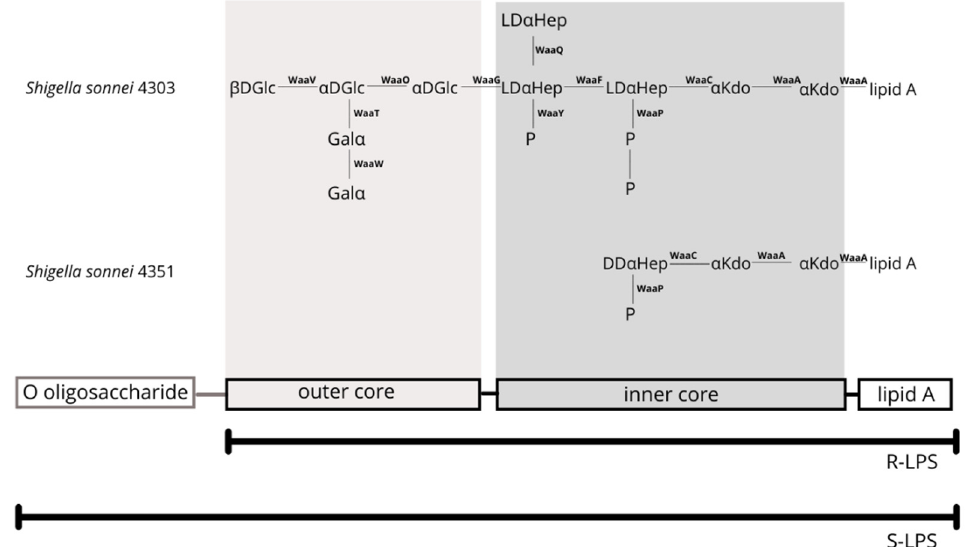
Figure 4. The structures of the R-type lipopolysaccharides from S. sonnei 4303 and S. sonnei 4351. No O-specific side chains are found in these bacteria. Genes involved in the LPS biosynthesis are indicated. The LPS in the S. sonnei 4351 strain contains a truncated core structure, due to the stop in the biosynthesis following the incorporation of a DD α Hep.